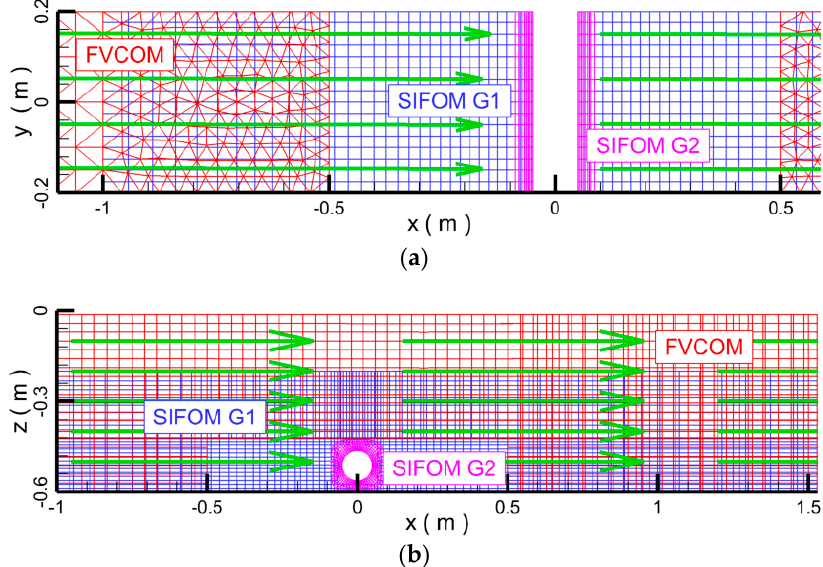
Figure 3. The calculation meshes. ( a ) The horizontal plane mesh at z = − 0.513 m. ( b ) The vertical plane mesh.